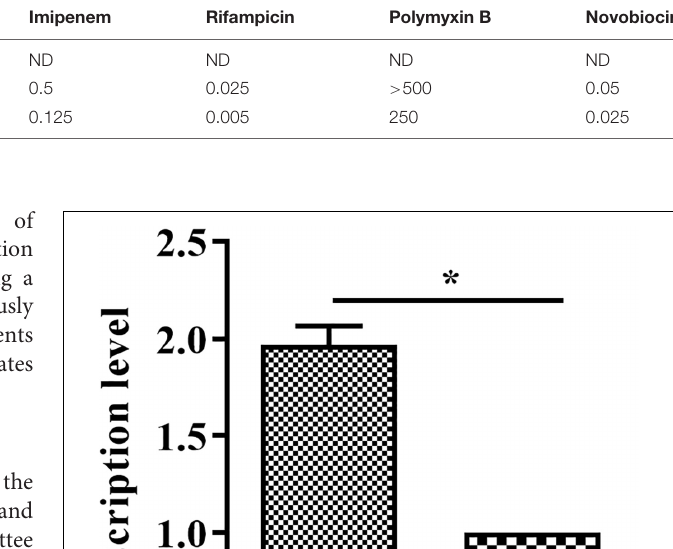
TABLE 2 | MICs [ µ g/ml or % (vol/vol)] of various antimicrobial agents for R. anatipestifer strains. Strain Glutaraldehyde SDS Imipenem Rifampicin Polymyxin B Novobiocin